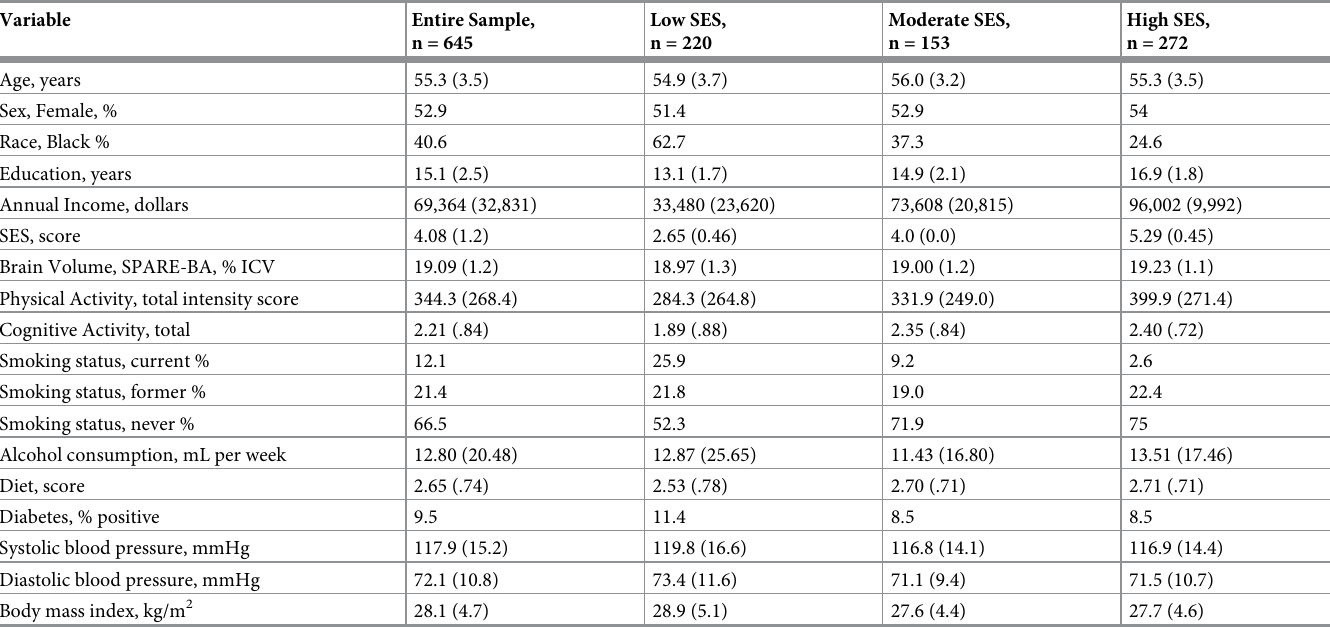
Table 1. Characteristics of study participants.